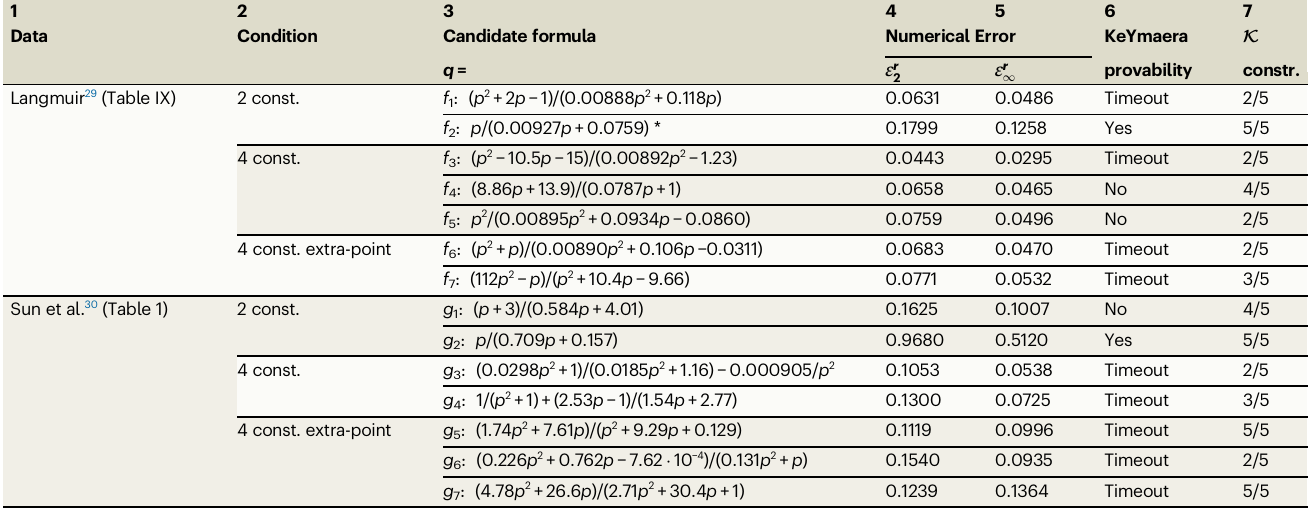
Sun et al. 30 (Table